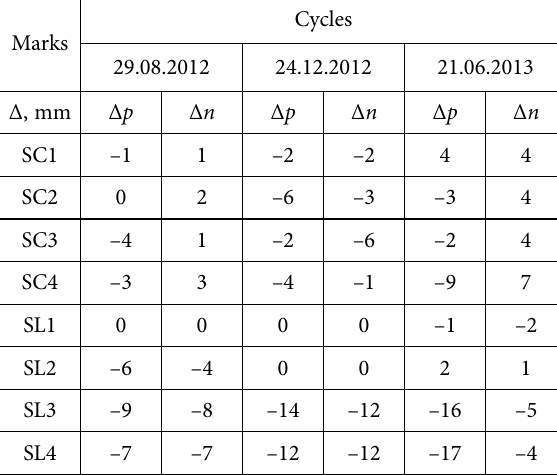
Table 2. Displacements, converted to the